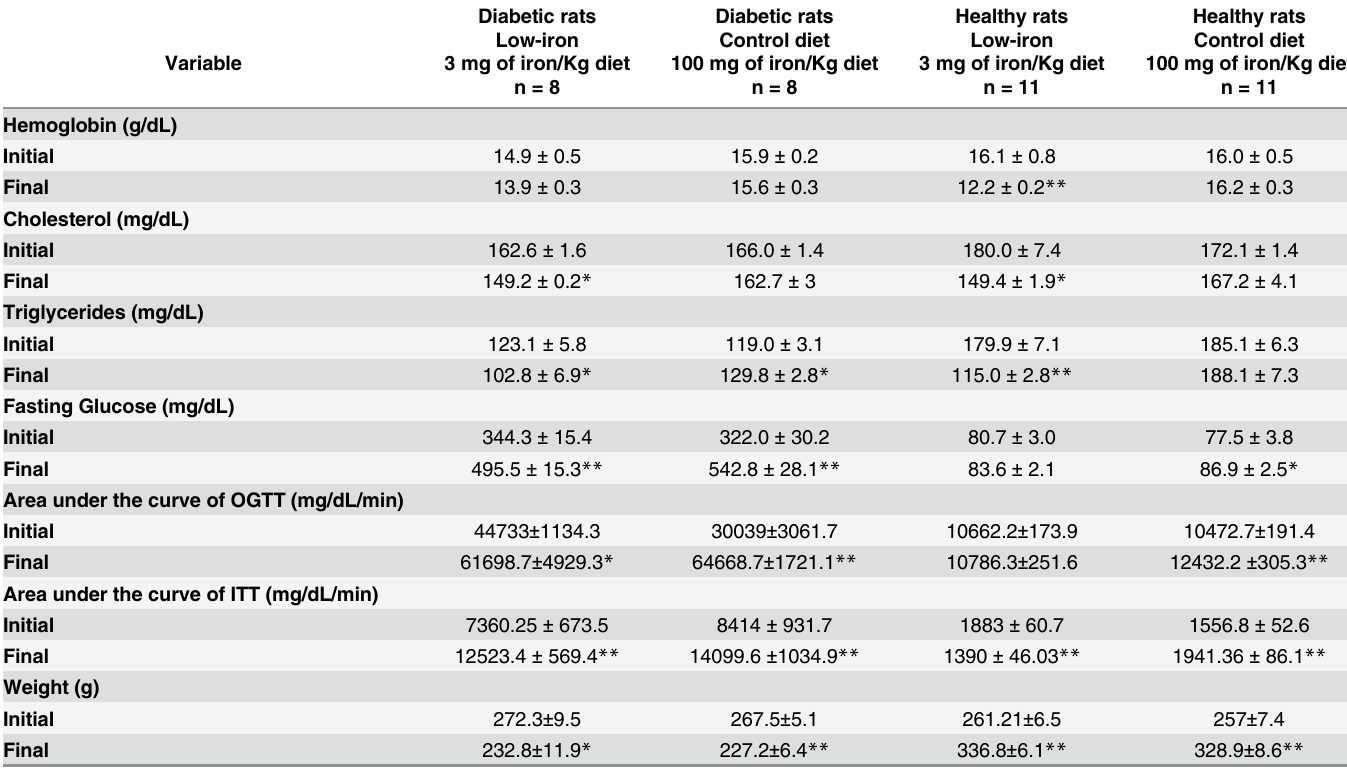
Table 3. Diabetic and healthy rats fed with low and control iron diet. p value from paired Student t-test at the beginning and end of intervention. Values are mean ± standard error of the mean. Two rats died during the study. Initial refers to values before intervention. Final refers to values after 8 weeks of dietary intervention. The paired Student t-test was calculated with the lower n indicated at the top of the